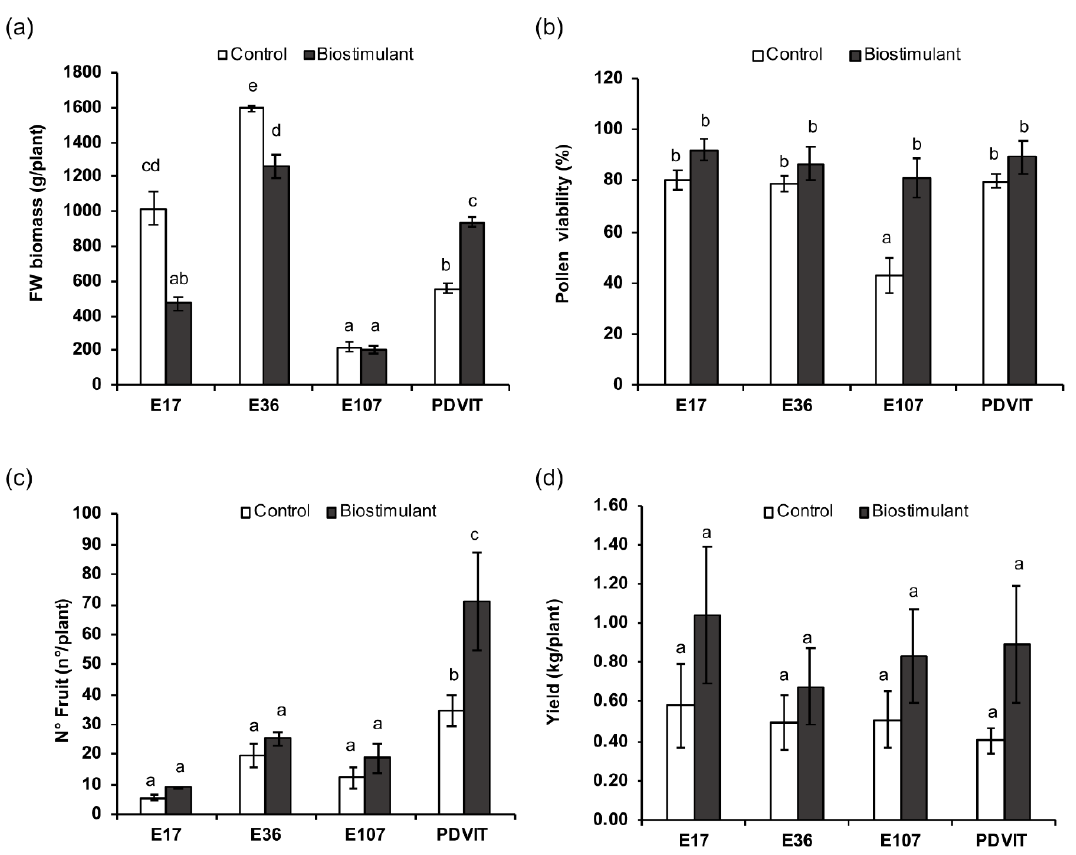
Figure 1. E ff ect of CycoFlow on: ( a ) Fresh weight (FW) biomass, ( b ) pollen viability, ( c ) fruit number, and ( d ) final yield in four tomato genotypes. Values are mean ± SE. Di ff erent letters indicate significant di ff erences based on Tukey-HSD test ( p ≤ 0.05).